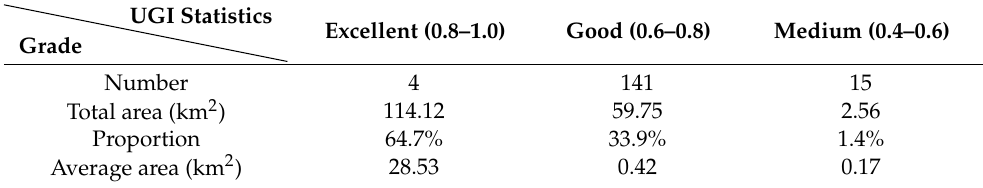
Table 8. UGI area and proportion of each greening quality grade.